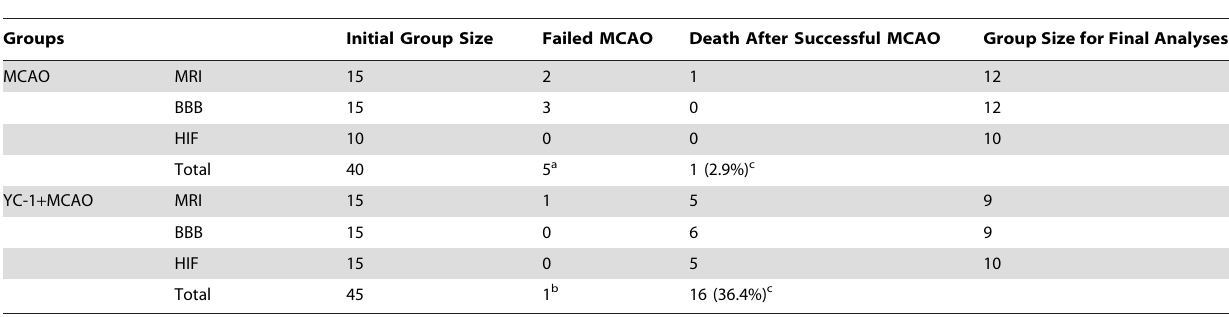
Table 1. YC-1-induced mortality of MCAO rats and group sizes for final